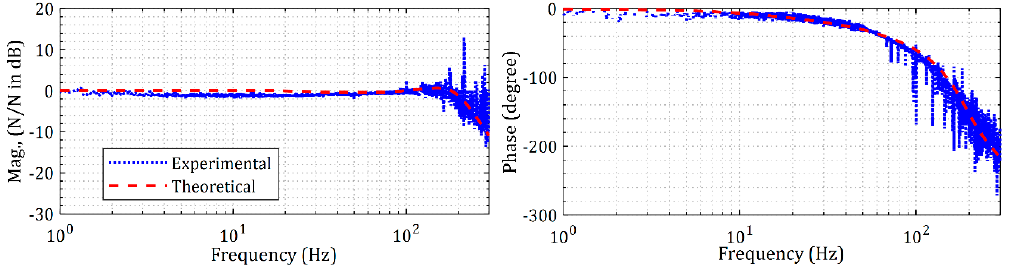
Figure 22. The experimental and theoretical closed-loop frequency response of the electro-hydraulic actuator.